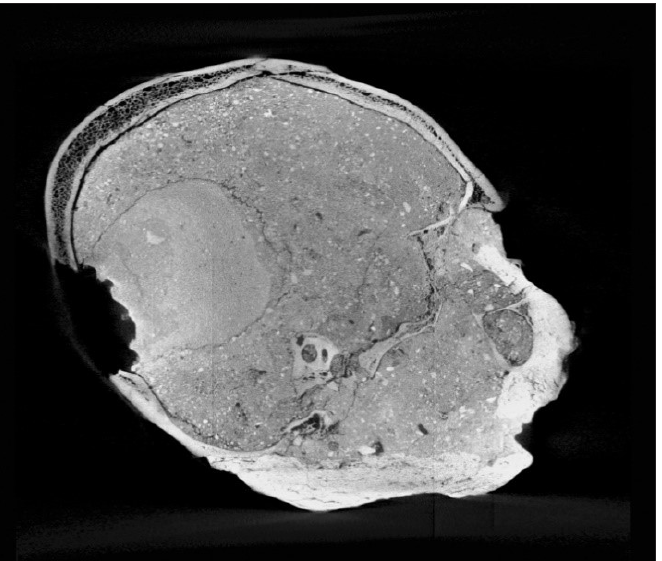
Figure 4: Sagittal slice from micro-CT image, this shows variation in the thickness of the cranium and the clay ball plugging the hole in the posterior of the crania (© Trustees of the Natural History Museum), (Voon